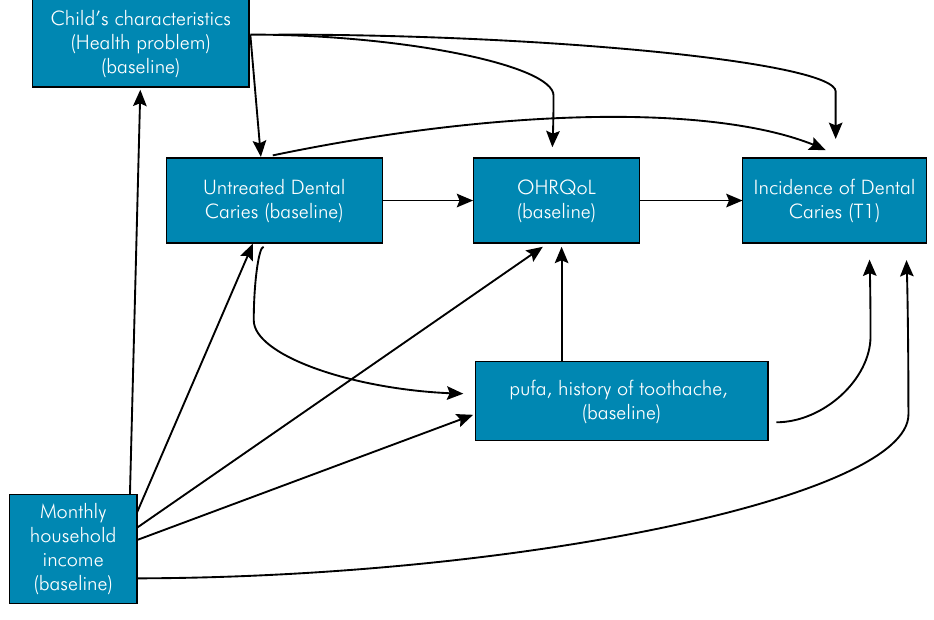
Figure 1. Flow chart describing the direction of the relation between the explanatory variables and new lesions of untreated dental